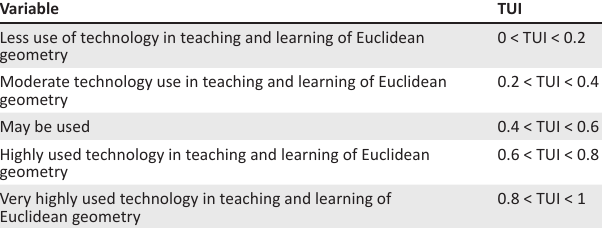
TABLE 1: Fractal stages of technology use in Euclidean geometry ( %